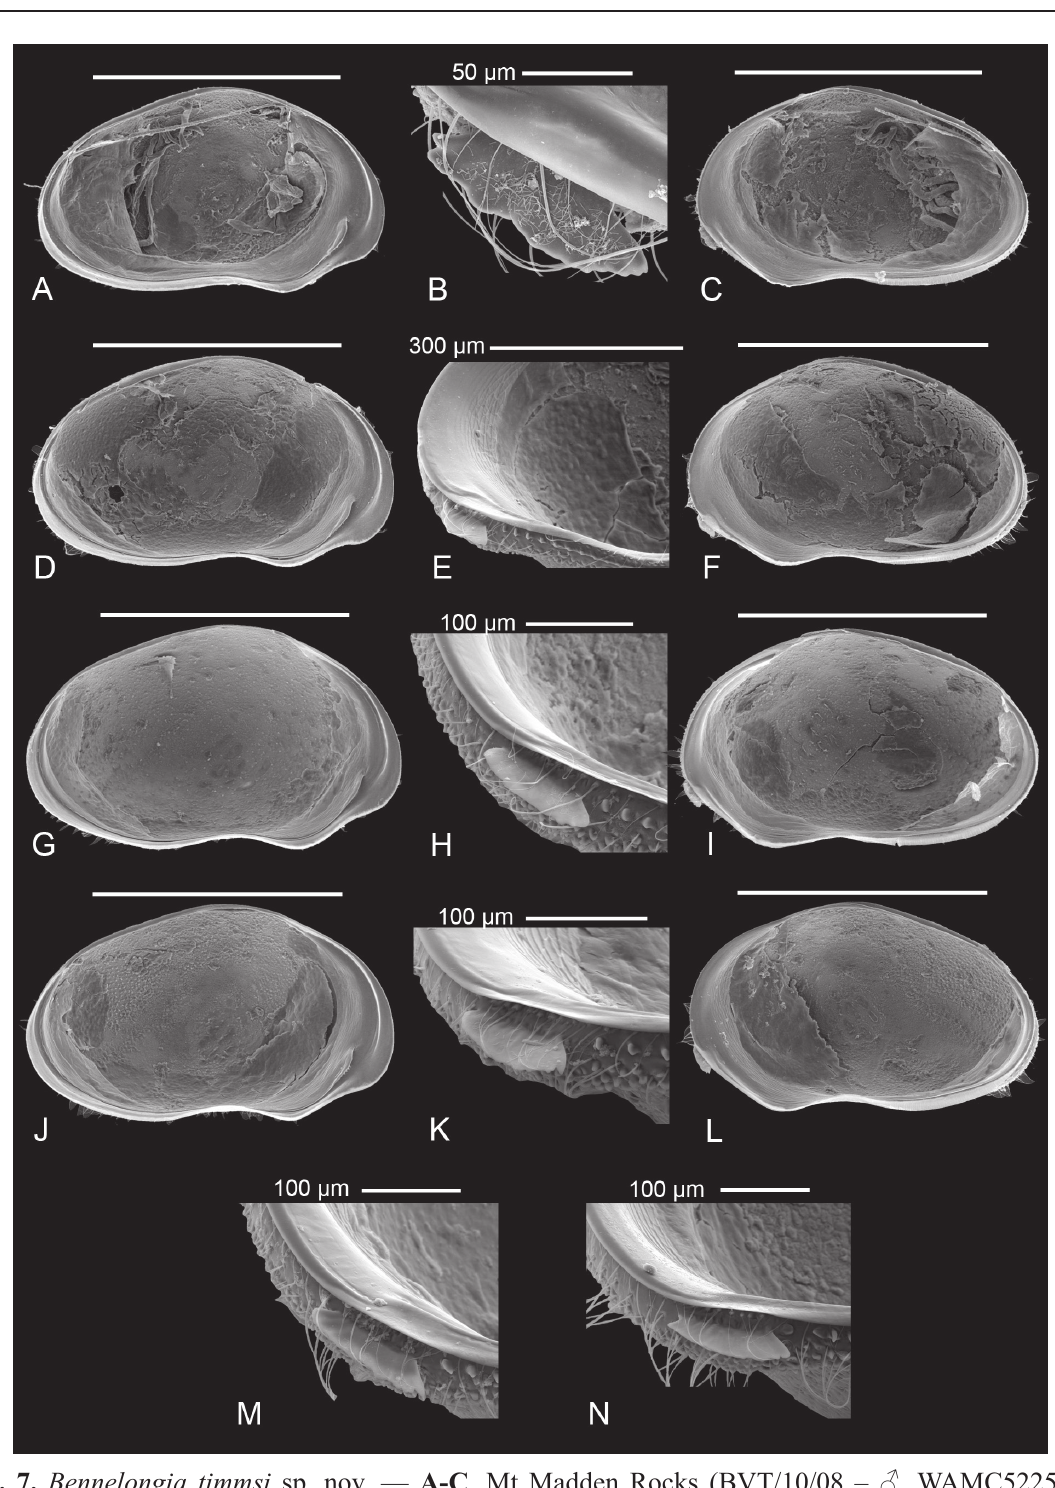
Fig. 7. Bennelongia timmsi sp. nov. — A-C . Mt Madden Rocks (BVT/10/08 – ♂, WAMC52255 – cryptic species a5). A . lVi. B . rVi, detail anterior, tilted. C . rVi. — D-F . anderson rock (BVt/10/03 – ♀, WAMC52245). D . lVi. E . rVi, detail anterior, tilted. F . rVi. — G-I . Paynes Find rock (BVt/10/01 – ♀, WAMC52239). G . lVi. H . rVi, detail anterior, tilted. I . rVi. — J-L . Grahams rock (BVt/10/02 – ♀, OC.3317). J . lVi. K . rVi, detail anterior, tilted. L . rVi. — M . Burracopin Rock (BVT/10/04 – ♀, Oc.3318), rVi, detail anterior, tilted. — N . King Rocks (BVT/10/06 – ♀, WAMC52250), RVi, detail anterior, tilted. scales = 1 mm unless otherwise